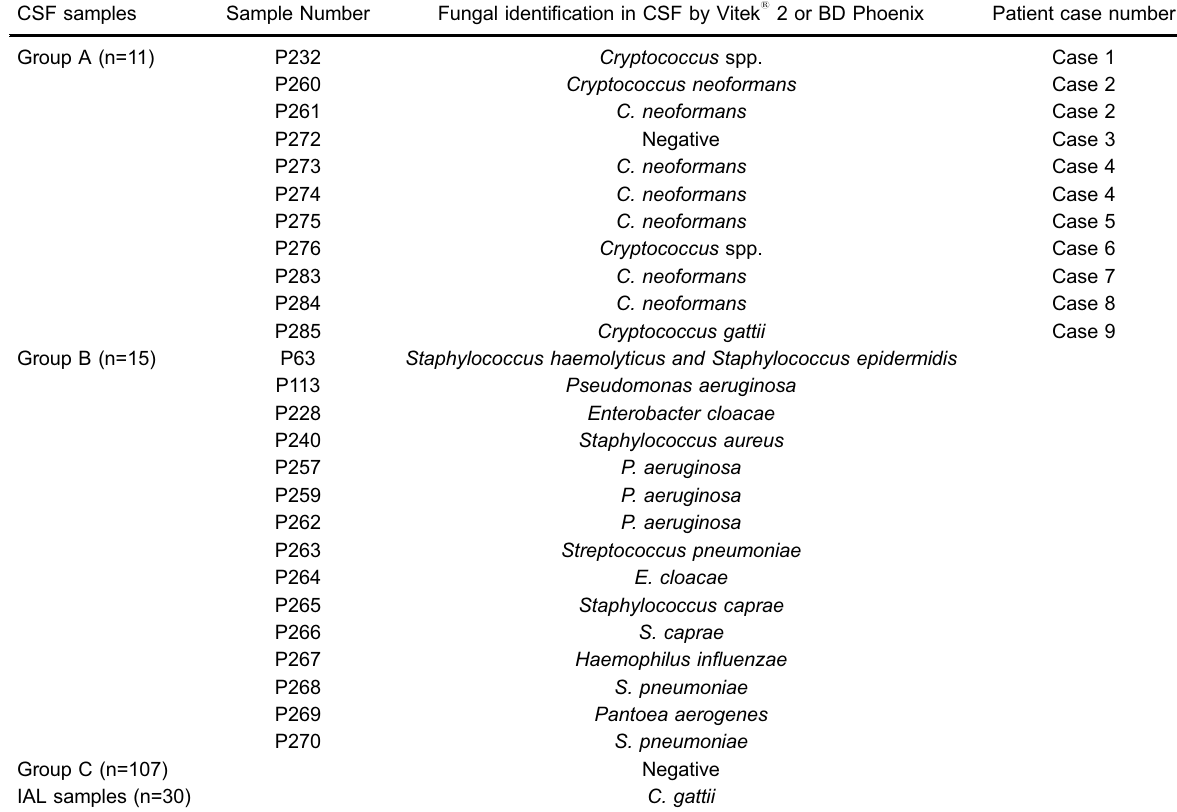
Table 1. Cerebral spinal fl uid (CSF) samples used in this study according to sample number and microbiological identi fi cation. CSF